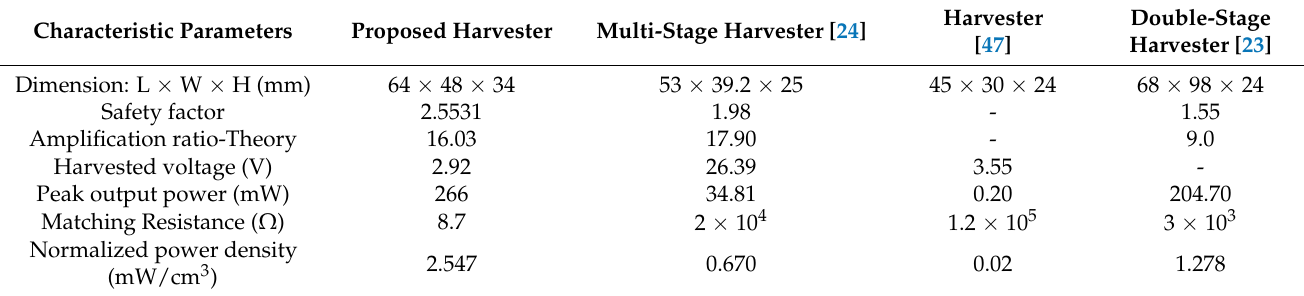
Table 9. Comparison of performance parameters with existing